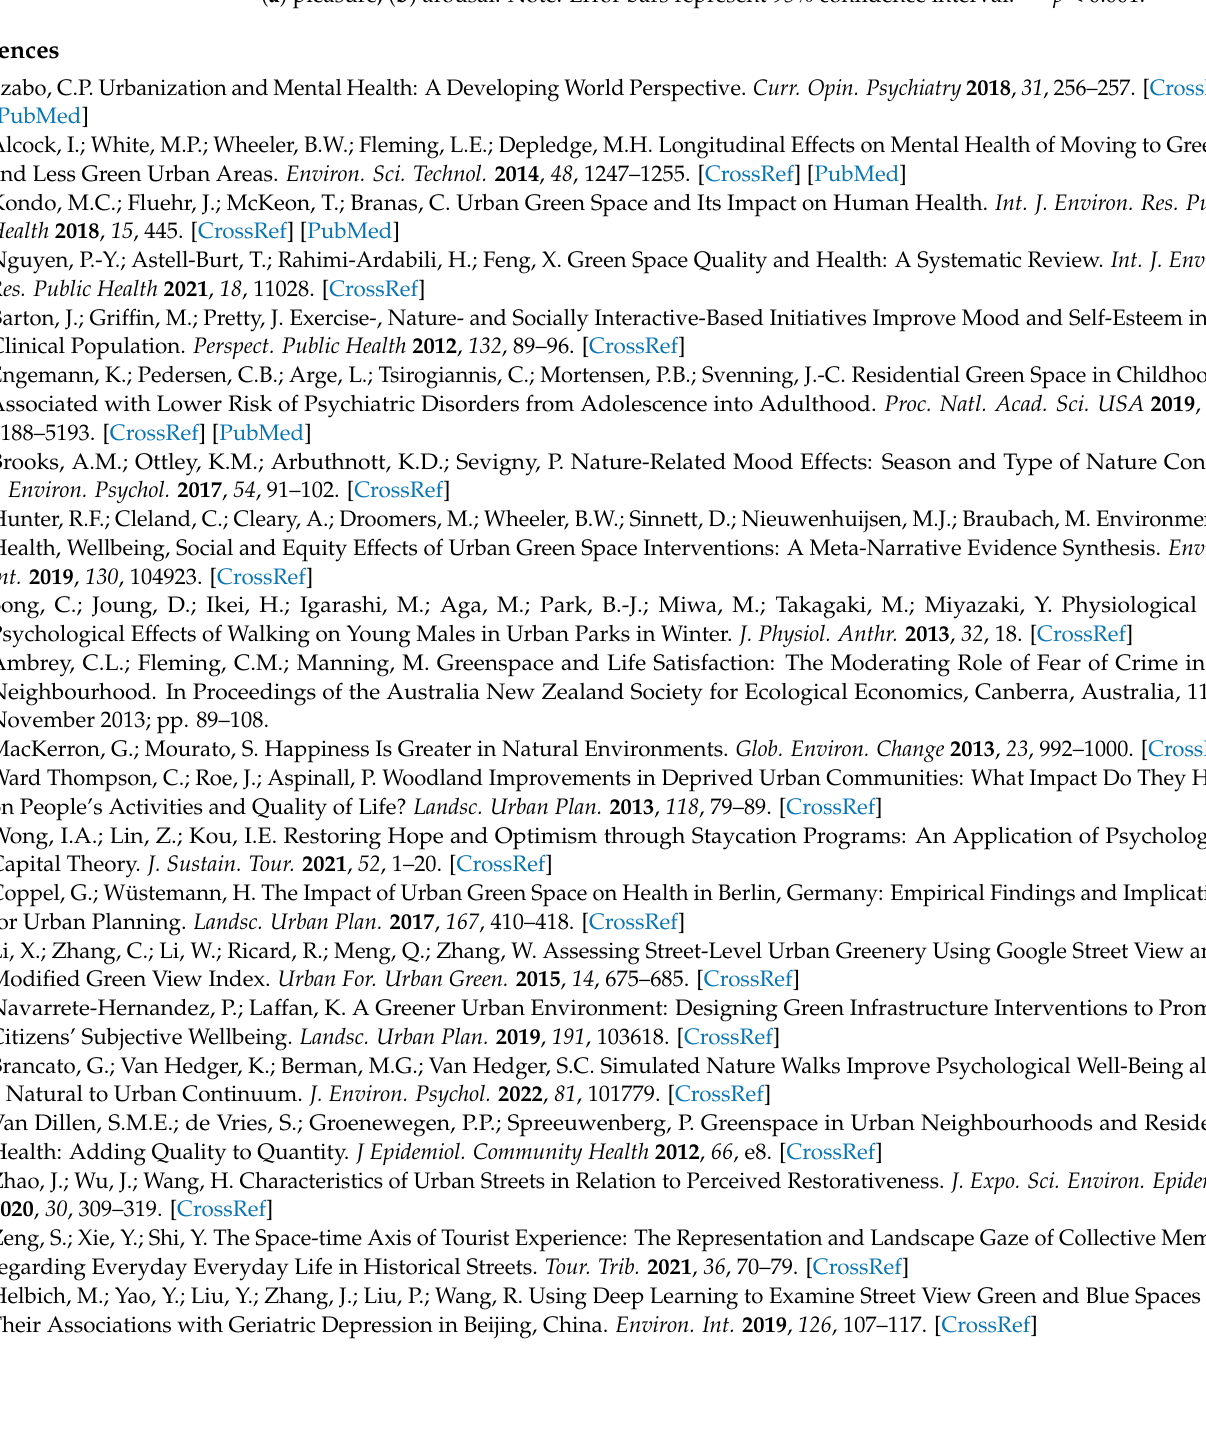
Figure A2. The impact of the three types of streets on tourists’ momentary emotional experience; ( a ) pleasure, ( b ) arousal. Note: Error bars represent 95% confidence interval. *** p 0.001.